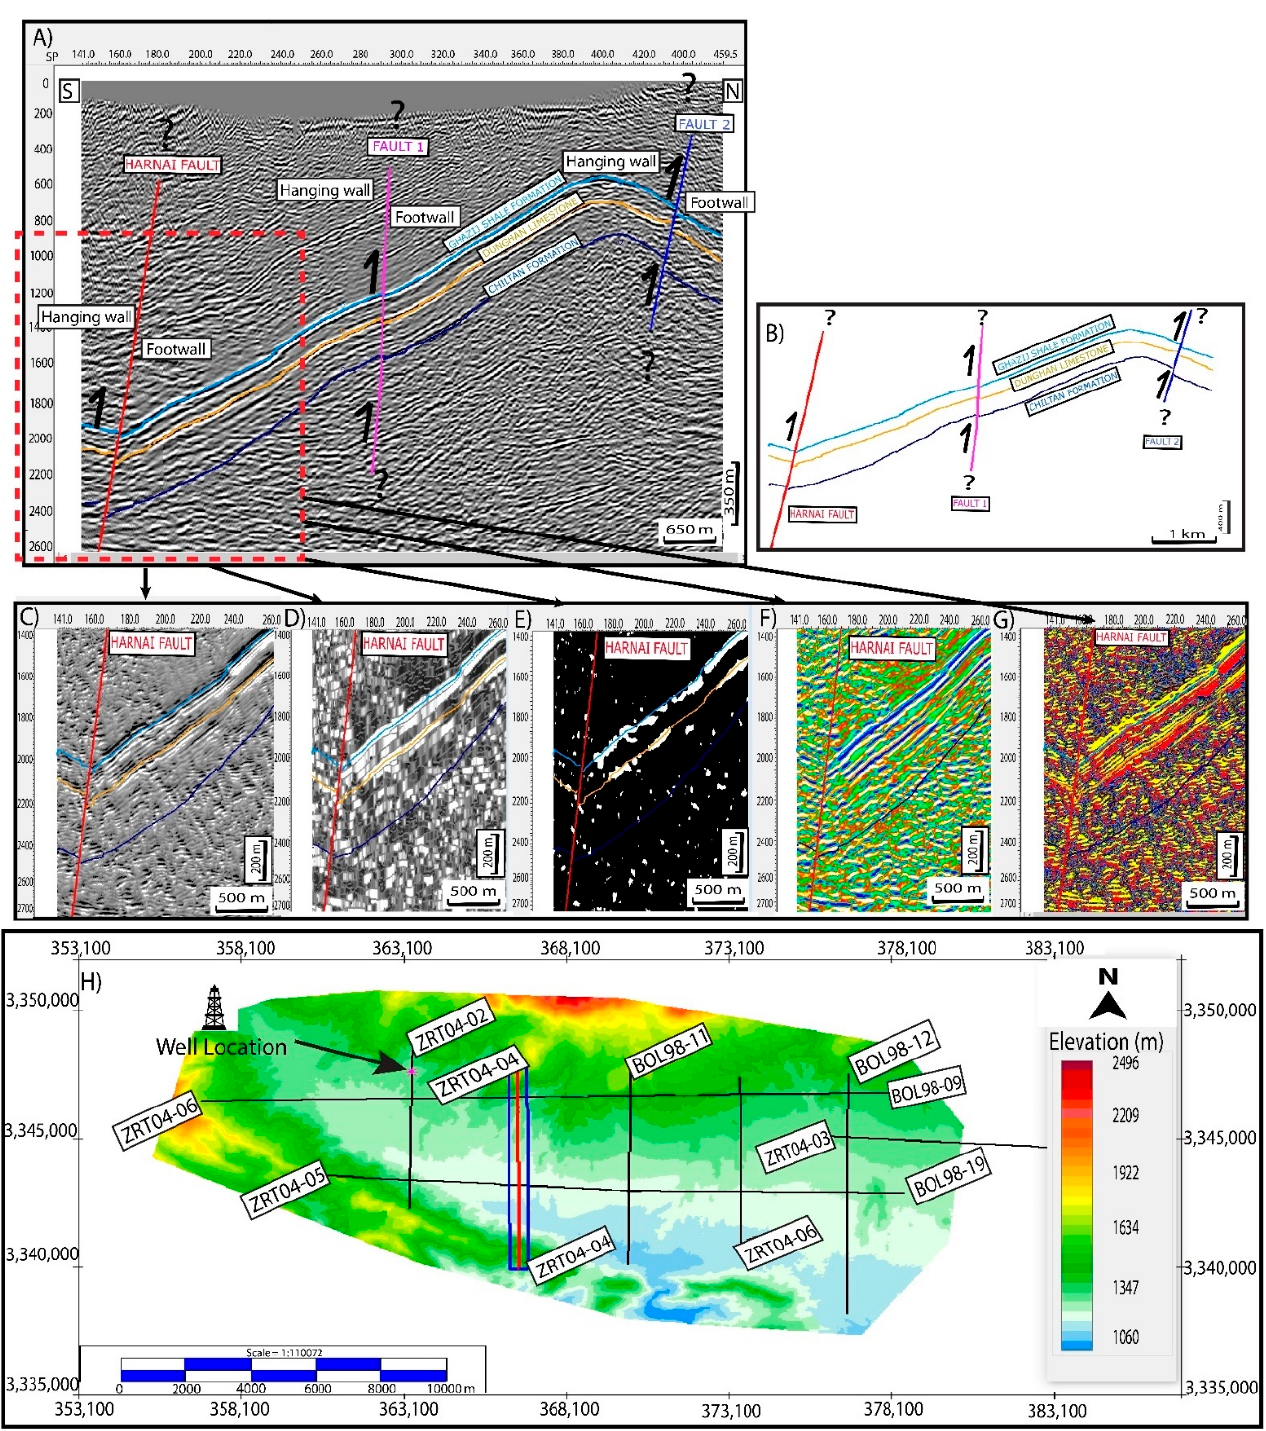
Figure 11. Interpretation of seismic line ZRT04-04. ( A ) The red dash line box shows the location of the Harnai Fault. ( B ) shows the model that extracts from the seismic section. ( C – G ) show the seismic attributes with Pseudo-relief ( B ), Average Energy ( D , E ), and Trace Envelope ( F , G ), respectively. ( H ) represents the location of the seismic section BOL98-11 highlighted in red color. The color depicts elevation (meters).